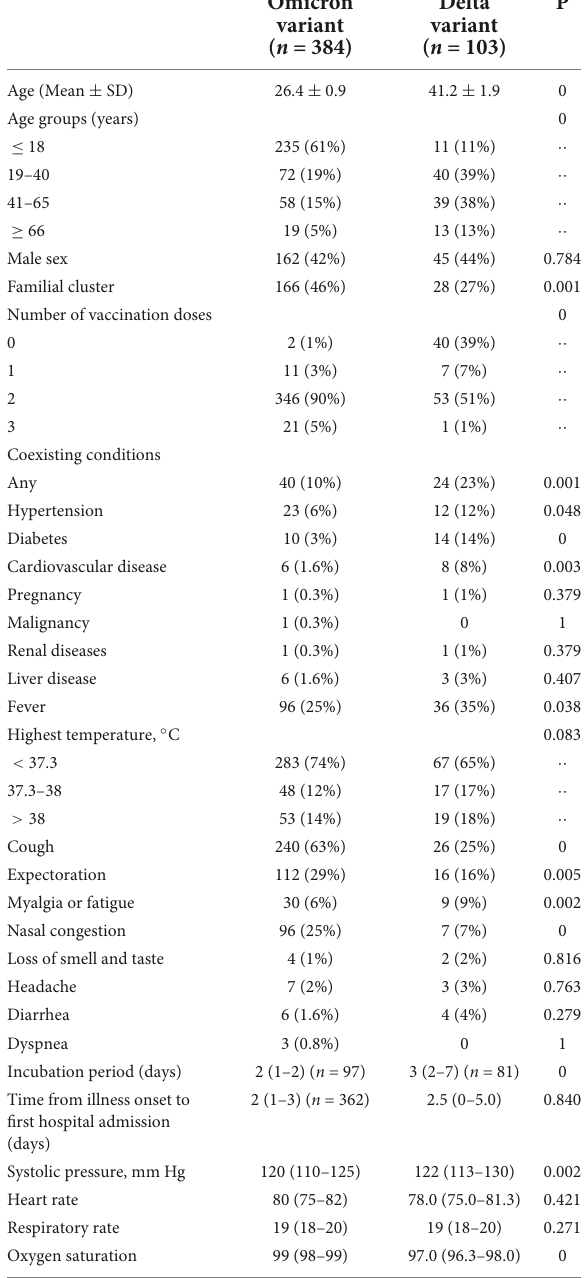
TABLE 1 Personal and clinical baseline characteristics of patients infected with the Omicron variant or Delta variant.